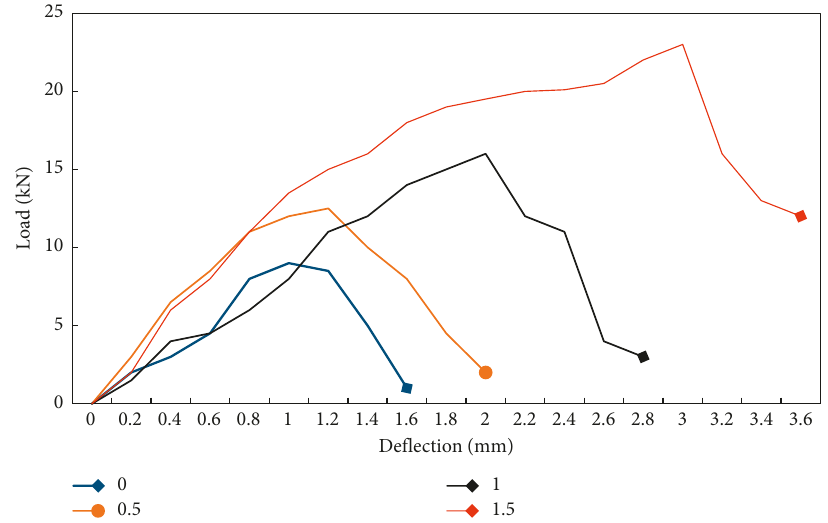
Figure 5: Load-deflection curves of specimens with four fiber content.